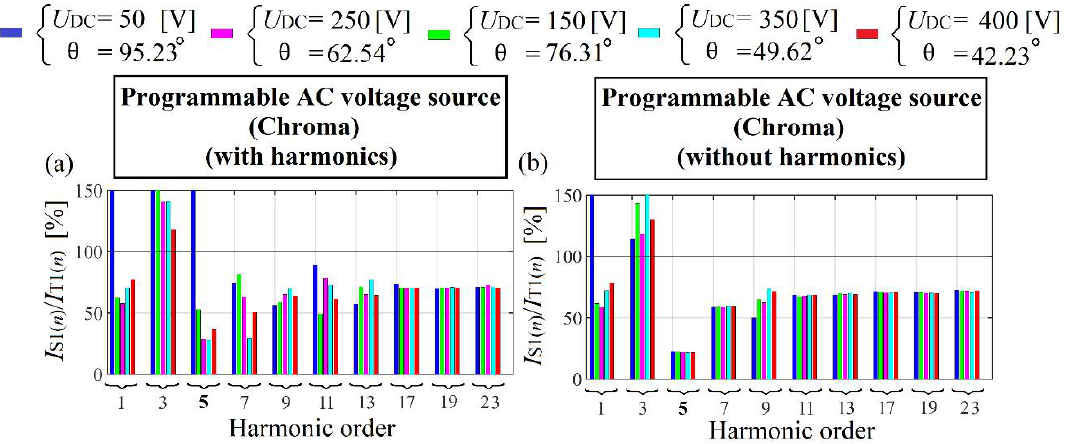
Figure 35. Current waveforms and spectrums measured at the load terminals when the programmable voltage source was with: ( a ) harmonics and ( b ) without harmonics. The line reactor L SS is considered.